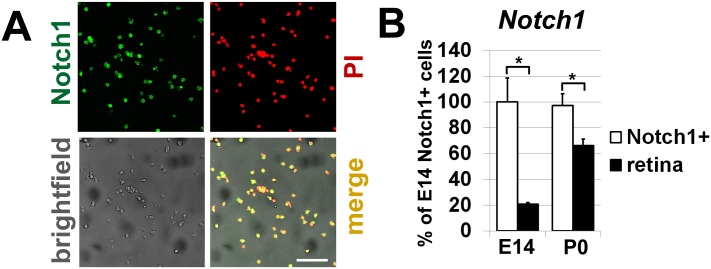
Immunomagnetic separation proved to be an effective method for positive selection of Notch1-specific cells from developing retinas.
A) The purity of isolated cells was tested using anti-Notch1 antibody (green). Propidium iodide (PI, red) was used to visualize the nucleus of the cell. Bar is 50 μm. B) The levels of Notch1 expression in isolated cells were higher compared to expression of Notch1 in whole retinas. Gene expression was measured by qRT-PCR. Results are expressed as a percentage of the corresponding value in the Notch1+ cells isolated from embryonic day 14 developing retinas ± SEM (*P < 0.05).